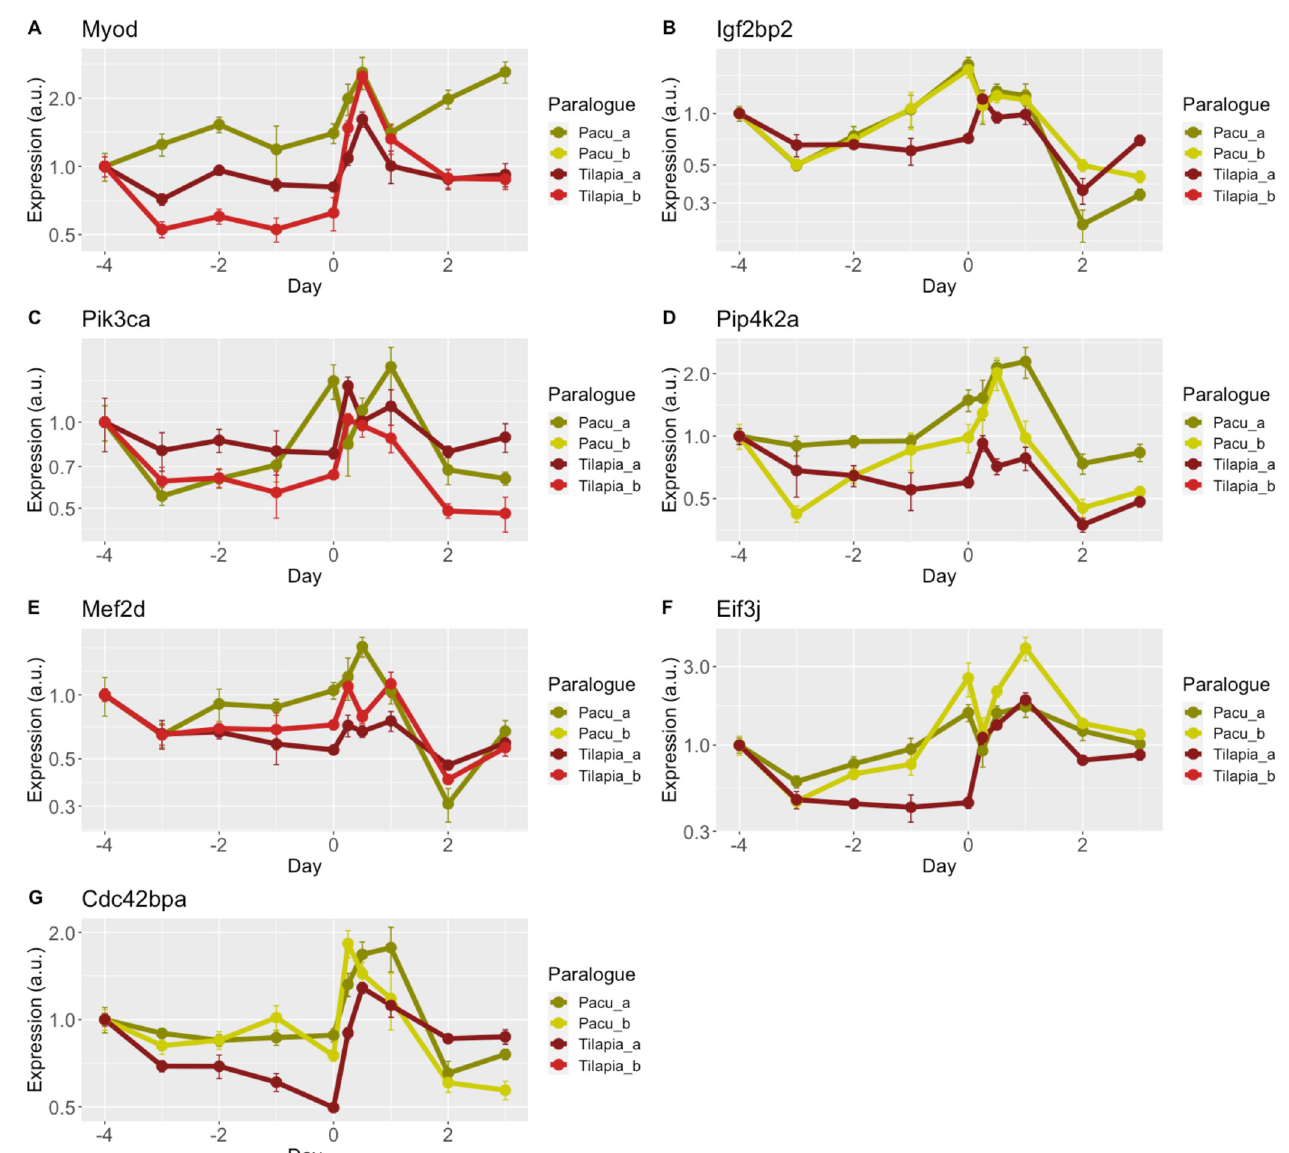
Fig 3. Lineage-specific ohnologs (LSOs) retained by redundancy. Gene duplicates showing signs of redundancy as the main molecular mechanism of retention. LSOs and singletons expression of (A) myogenic differentiation ( myod ), (B) insulin like growth factor 2 mRNA binding protein 2 ( igf2bp2 ), (C) phosphatidylinositol-4 , 5-bisphosphate 3 kinase catalytic subunit alpha ( pik3ca ), (D) phosphatidylinositol-5-phosphate 4 kinase type 2 alpha ( pip4k2a ), (E) myocyte enhancer factor 2D ( mef2d ), (F) eukaryotic translation initiation factor 3 subunit j ( eif3j ), (G) cdc42 binding protein kinase alpha ( cdc42bpa ) in pacu (green lines) and tilapia (red lines) skeletal muscle are represented as relative values, Mean ± SE (n = 6).